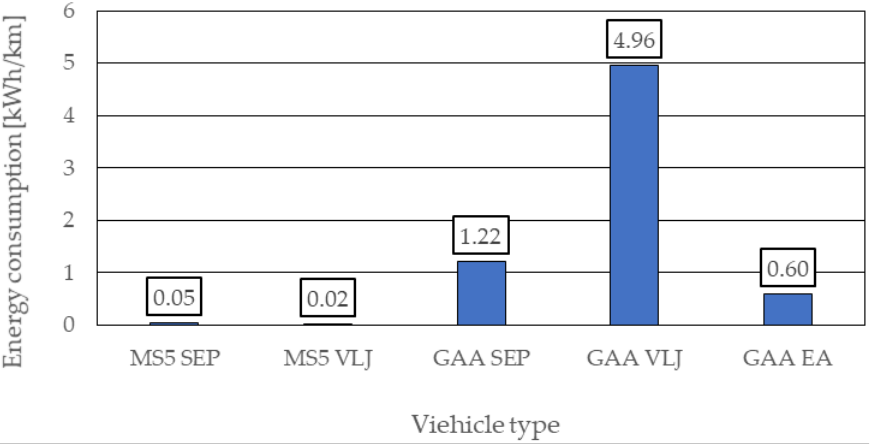
Figure 9. Comparison for different modes of transport: passenger cars, general aviation aircrafts and flight simulator test result made on CKAS Motion Sim.